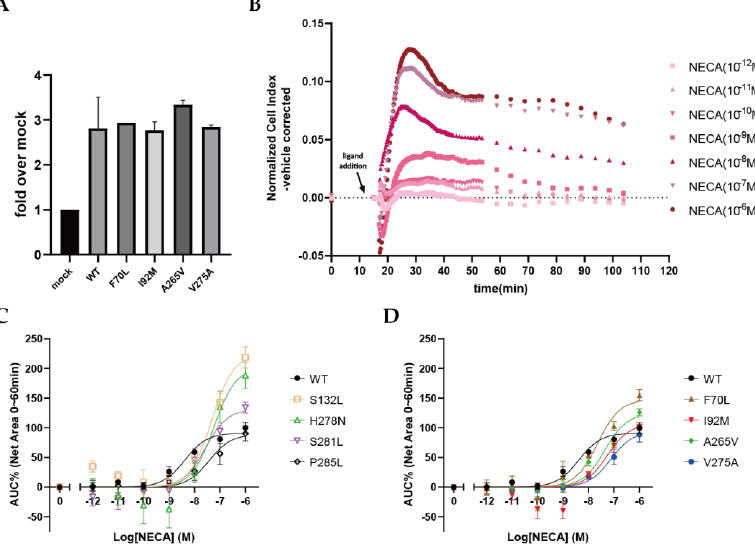
Figure 5. Functional characterization of wild-type and mutant A 2A ARs via NECA stimulation of transiently transfected HEK293T cells, using a label-free impedance-based cell-morphology assay. ( A ) Expression levels of transiently transfected WT and mutant A 2A ARs on HEK293T cells, measured with an enzyme-linked immunosorbent assay. Data are shown as mean ± SD of two independent experiments performed in quintuplicate. ( B ) Representative graph of vehicle-normalized cell index after stimulation with different concentrations of NECA of the wild-type A 2A AR. Graphs of mutant A 2A ARs are shown in Figure S2. ( C , D ) Concentration–response curves of NECA for wild-type and mutant A 2A ARs derived from the area under the curve within 60 min after ligand addition. The response to vehicle was normalized to 0%, and the response to 1 µ M NECA of the wild-type receptor was set to 100%. Data are shown as mean ± SEM of three independent experiments, each performed in